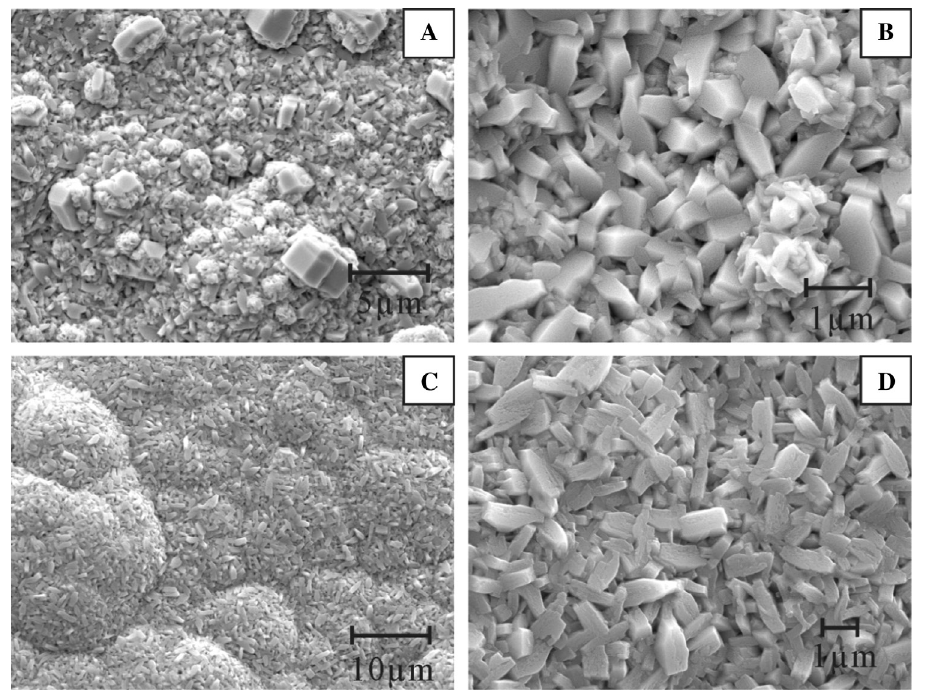
films. (A, B) and (C, D) are the microstructure of TiB 2